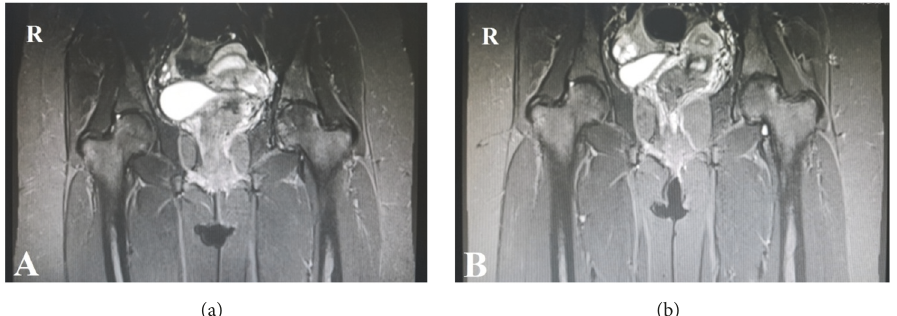
Figure 1: T1-weighted MRI image showing grade II ONFH of the left hip before ESWT (a). The lesion regressed to grade I at 2-year follow-up after ESWT